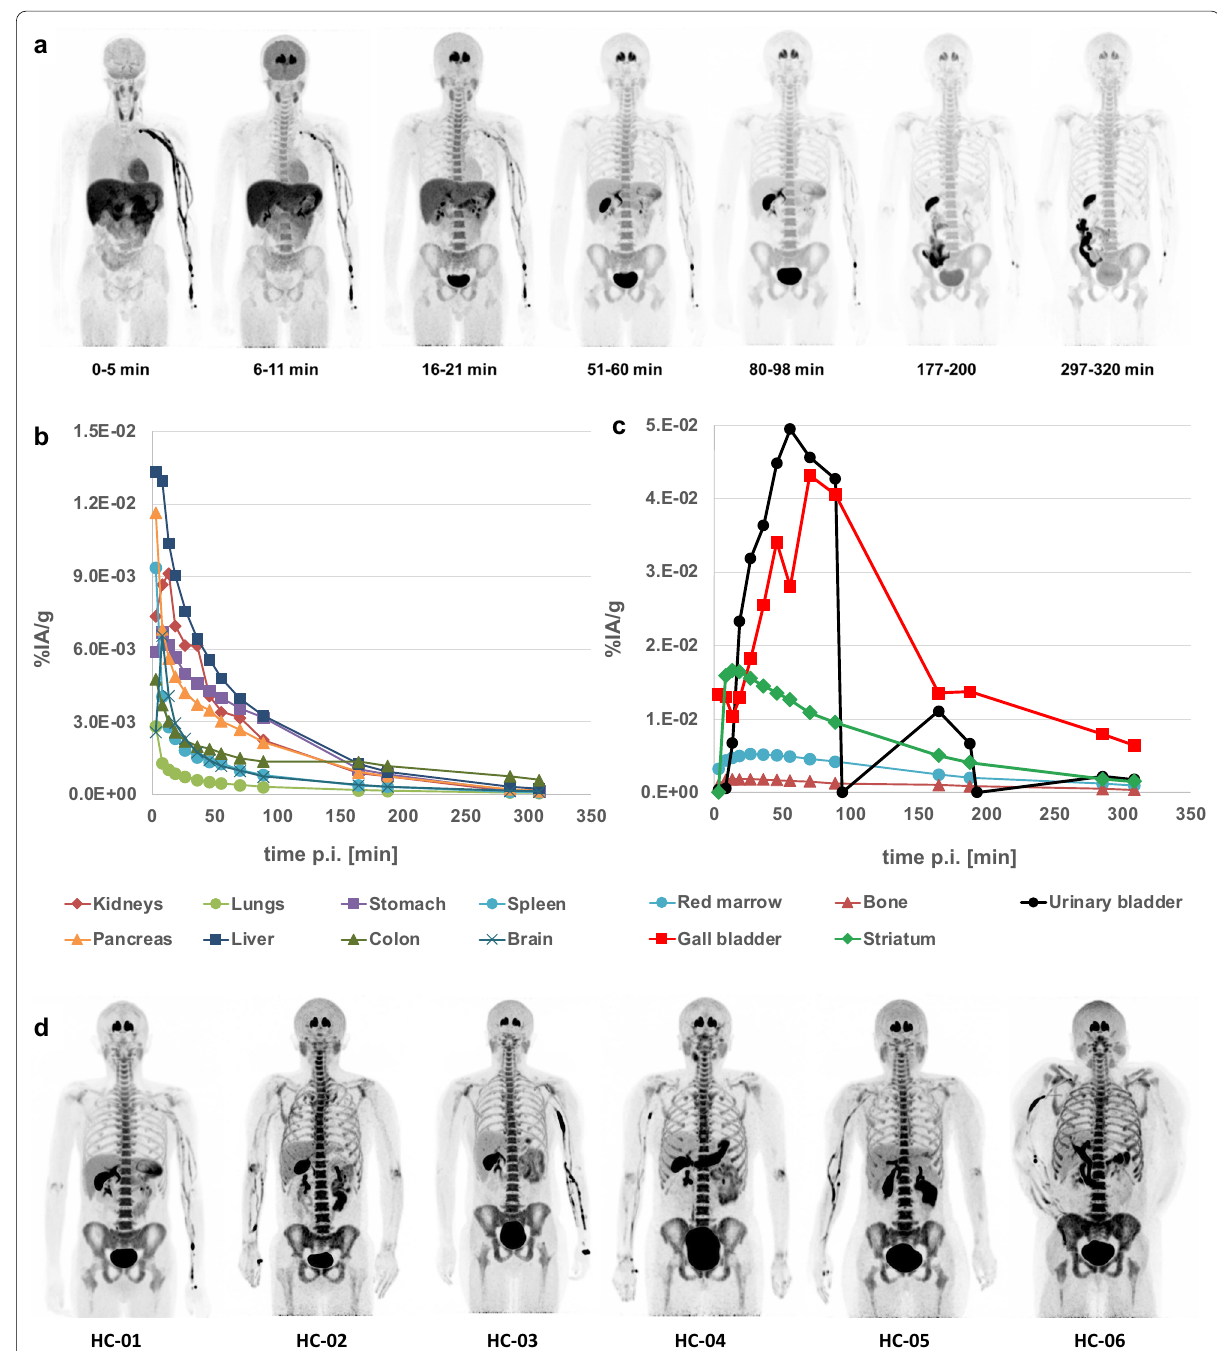
Fig. 1 a Representative maximum-intensity projections for a series of PET images over 320 min after injection of [ 18 F]PR04.MZ, b representative TACs for subject 1 and for major organs expressed as per cent injected activity (%IA/g), c representative TACs for urinary bladder, gall bladder, striatum, red marrow and bone, d representative maximum-intensity projections of PET images of all HCs approximately 60–90 min after injection of [ 18